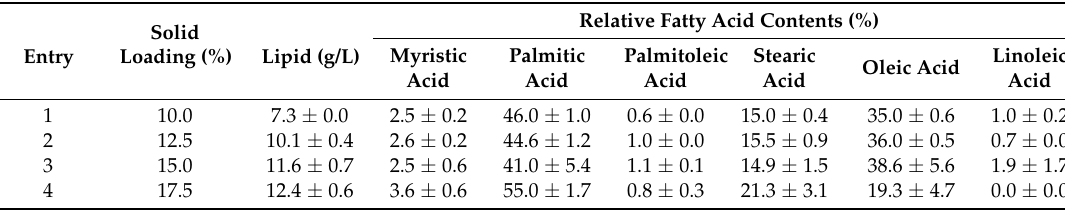
Table 5. Fatty acid compositional profiles of lipids produced from DryPB corn stover by R. toruloides according to the PreSSLP